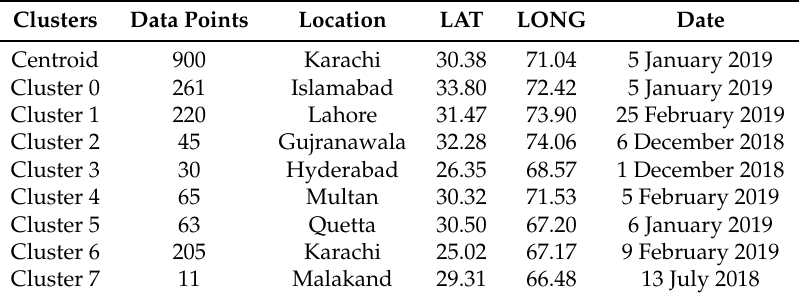
Table 4. Clusters of crimes in Pakistan on the basis of k-Means algorithm.